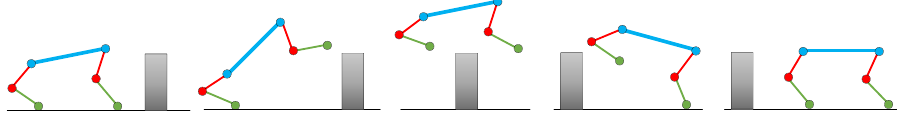
Figure 1. The process whereby a quadruped robot jumps over obstacles. The process of vertical jumping is similar to that of jumping over obstacles. In the process of jumping, the robot uses four legs to exert force at the same time and does not change the pitch angle of the body. The pitch angle is set to zero. The vertical jump process is shown in Figure 2.